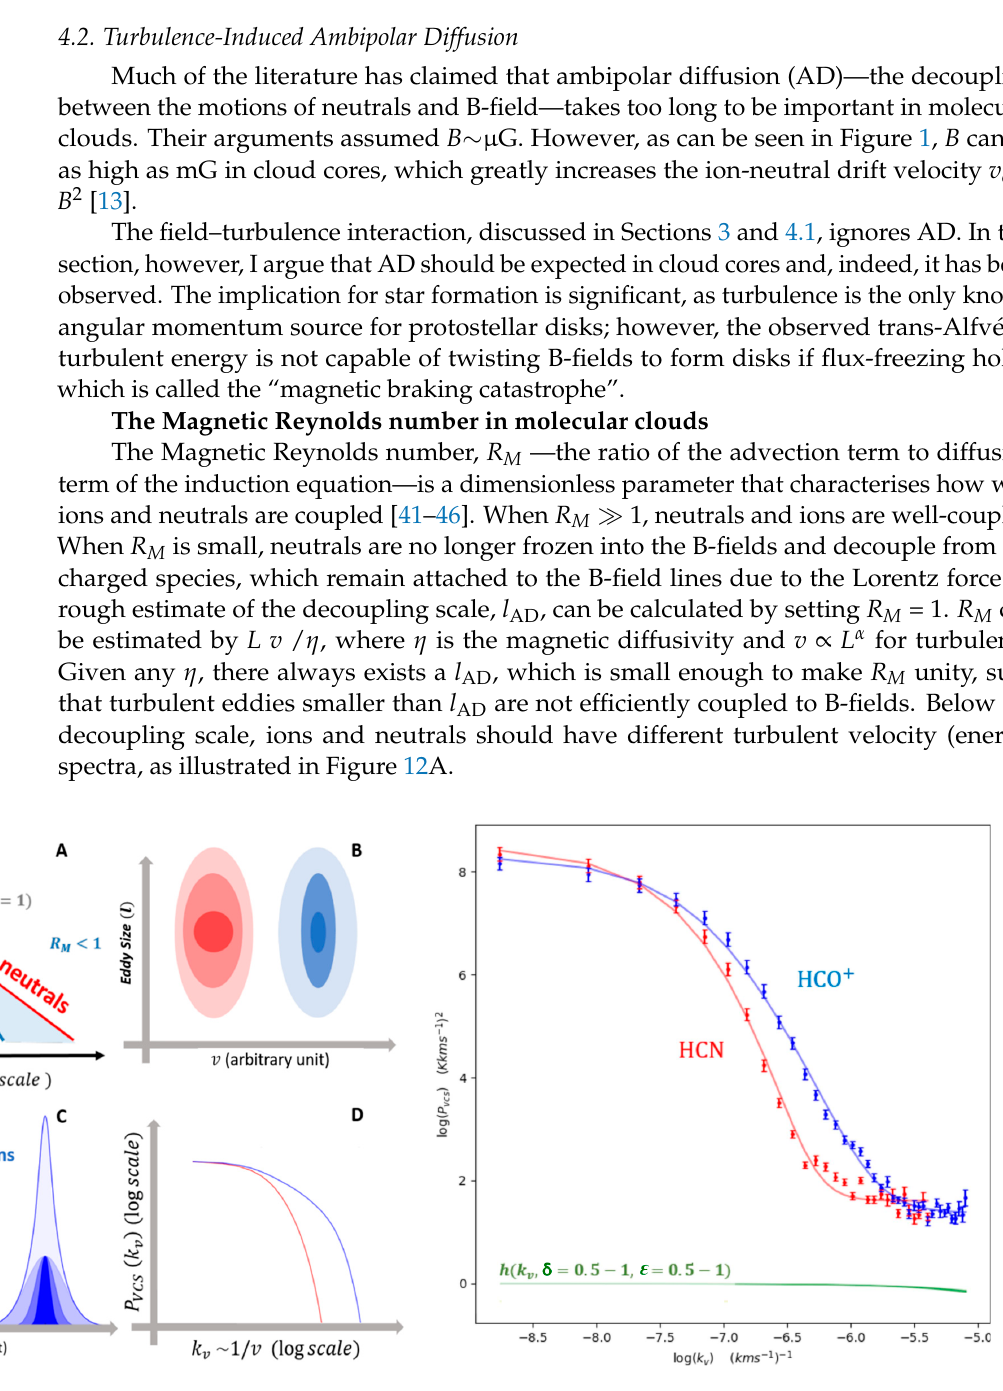
Figure 12. An illustration of turbulence energy spectra, emission line spectra and velocity coordinate spectra (VCS). Panel A : Illustration of a turbulence energy spectrum (in arbitrary units). The velocity dispersion/linewidth measured at scale l is proportional to the integration of the turbulent energies contributed by all eddies of size smaller than l . The turbulence energy in ions is dissipated steeply at scales smaller than l AD , due to turbulence-induced AD. Panel B : Illustration of mapping turbulent eddies from real space to spectral lines (velocity space). In real space, three eddies with the same density have different sizes and velocity dispersion. The larger the velocity dispersion of an eddy, the larger the extent of it in the velocity space. Here, the largest eddy of these two species, neutrals (red) and ions (blue), share the same velocity disper- sion. Due to the difference in the turbulent energy spectra (see Panel A ), the energy carried by the small ions eddies de- creases faster with the scale. Panel C : Illustration of Gaussian-type emission line spectra of the eddies in Panel B . The area under these Gaussians scales linearly with the sizes of the eddies in Panel B , while the velocity dispersions of the red and blue Gaussians are scaled with σ v ∝ l 1/3 and σ v ∝ l , respectively, to imitate the difference in the turbulence energy spectrum ( Panel A ). The eventual spectral lines (solid line) are given by the collective contributions of these profiles from individual eddies. Panel D : The VCSs of the spectral lines in Panel C . For ions, the spectral line in Panel C is narrower; thus, the VCS should contain more power in larger k v . By studying the behaviour in Fourier space, VCS recovers the statistical descrip- tion of the turbulence spectrum. Right panel : Comparable to Panel D , here the VCS obtained for HCN and HCO + (4-3) from NGC 6334 III in log-scale is shown. The best fits of the VCS are shown as solid lines. The effect of hyperfine structures enters as an extra factor in addition to the VCS; that is, (cid:1842) (cid:3035)(cid:3052)(cid:3043)(cid:3032)(cid:3045) ((cid:1863) (cid:3049) ) = ℎ((cid:1863) (cid:3049) ,(cid:2012),(cid:2013))(cid:1842) (cid:3023)(cid:3004)(cid:3020) ((cid:1863) (cid:3049) ) (see text). As it is presented in log– log space, the extra factor would simply up/downshift the VCS. The green line, ℎ((cid:1863) (cid:3049) ,(cid:2012),(cid:2013)) , demonstrates how the inclusion of the two brightest hyperfine structures would affect the behaviour of the VCS, with exaggerated intensities, (cid:2012) and (cid:2013) , ranging from 0.5 to 1 times of the main-line intensity. It is clear that the effect from h is negligible. For a weakly ionized plasma, such as a molecular cloud, the general form of Ohm’s law is